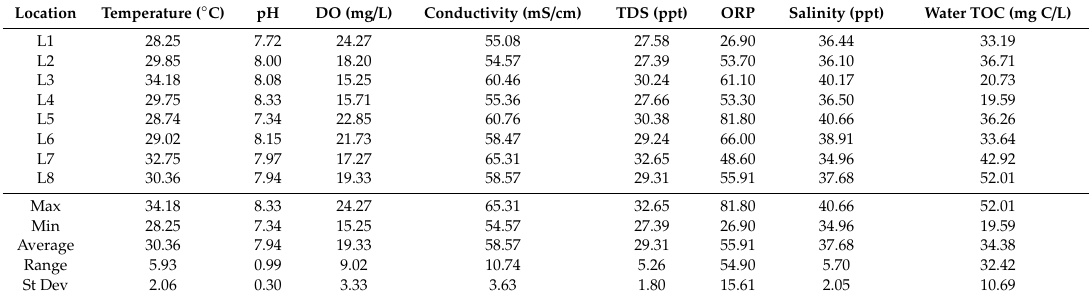
Table 1. Surface water quality and descriptive statistics at Umm Al Quwain mangroves, UAE. Location Temperature ( ◦ C)